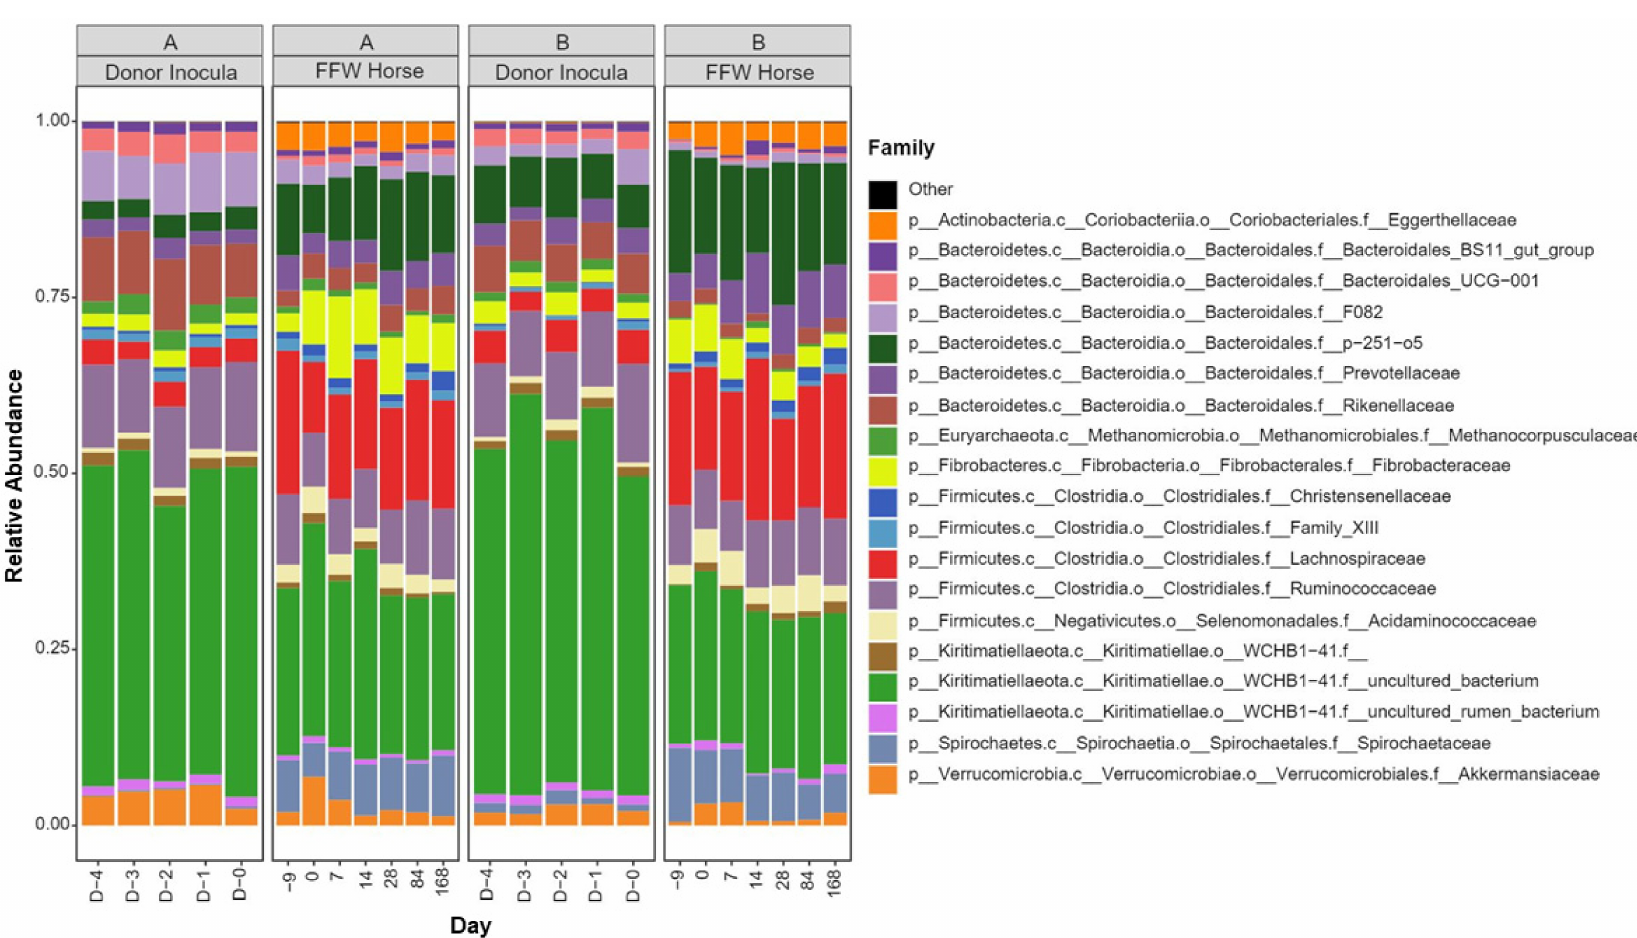
Figure 6. Taxonomic summary of the donor inocula and FFW horse faecal microbiota samples at the family level. For both donor animals (i.e., A and B), average profiles are shown per donor animal for the donor inoculant that was prepared on the five consecutive days (i.e., D-4 to D0). Average profiles for faecal microbiota of the FFW horses over the sampling time course (i.e., day –9 to day 168) are shown grouped based on the donor animal that was used during their FMT. The taxa listed in the key are shown in the order that they are appear within the